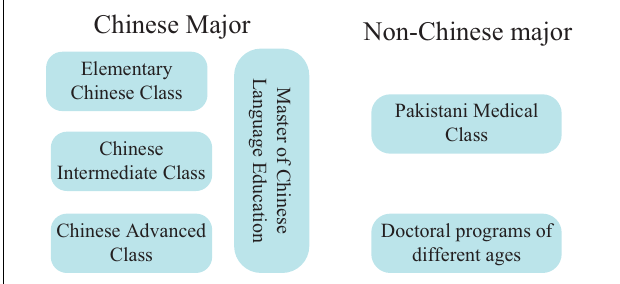
FIGURE 6 | Analysis of the survey results of the relations between learning strategies and their majors of foreign students.